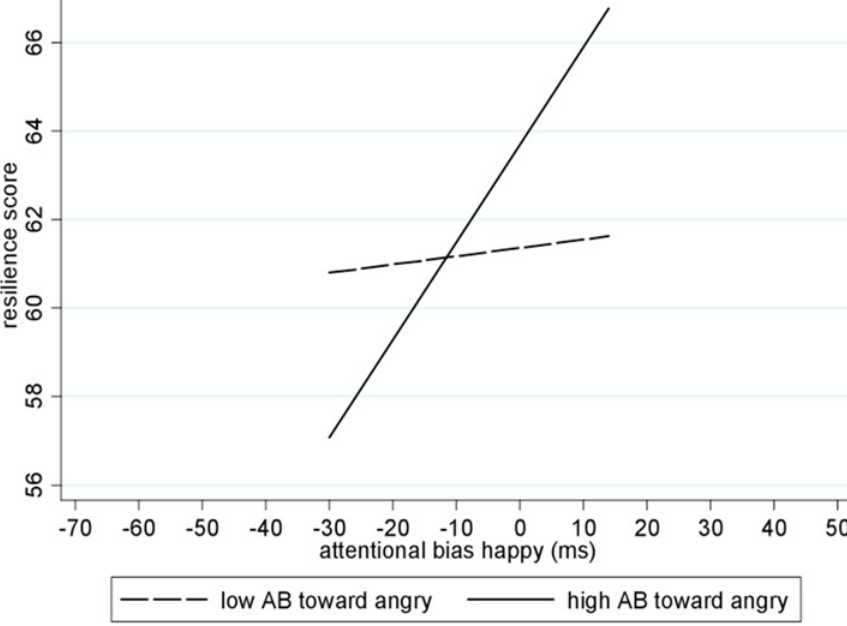
high AB towards angry stimuli (continuous line) represents values of 1 SD above the